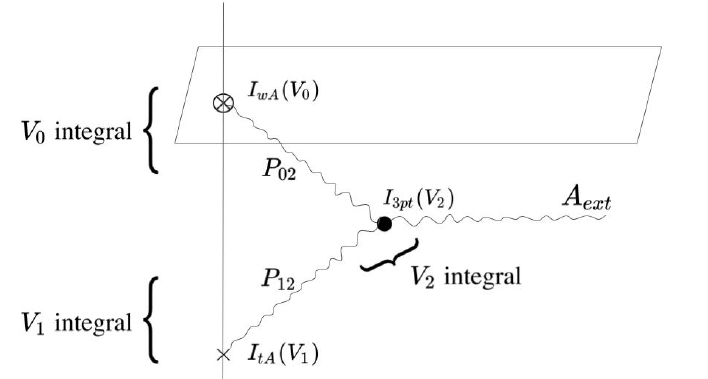
Figure 9: The 1-loop Feynman diagram associated with the A → A ⊗ W ∞ coproduct. All the ingredients are explicitly